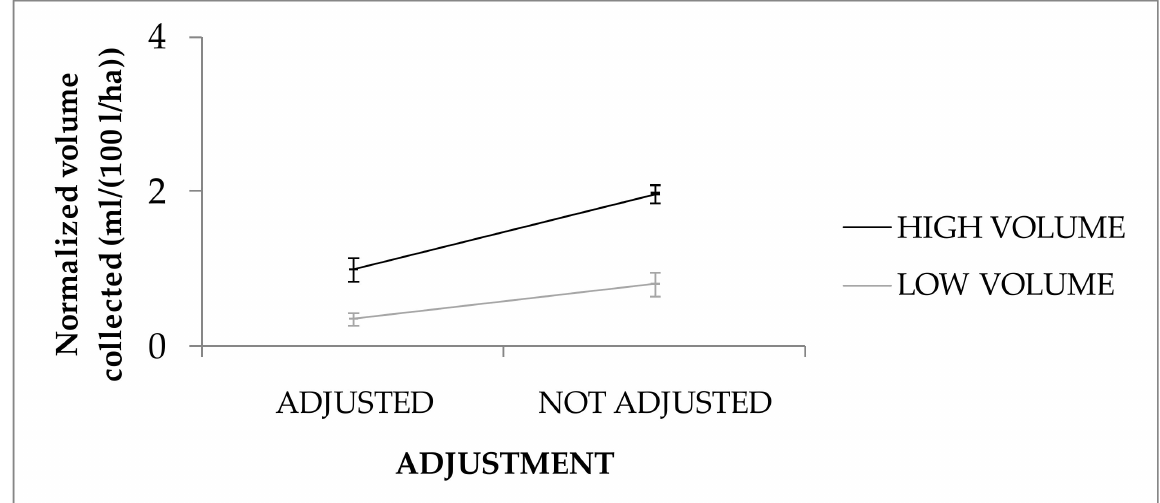
Figure 15. Volume rate × Adjustment interaction effect on the normalized volume collected above the Canopy height (mean ± SE) with the T sprayer.